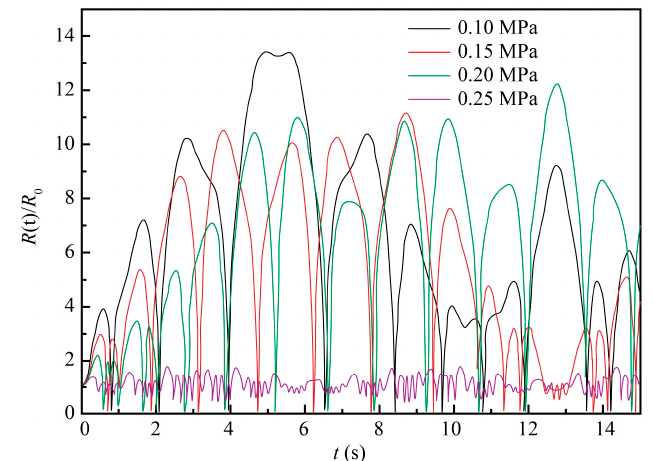
Figure 5. Evolution of cavitation bubble oscillation amplitude at four di ff erent pressure values of the electrolyte solution.